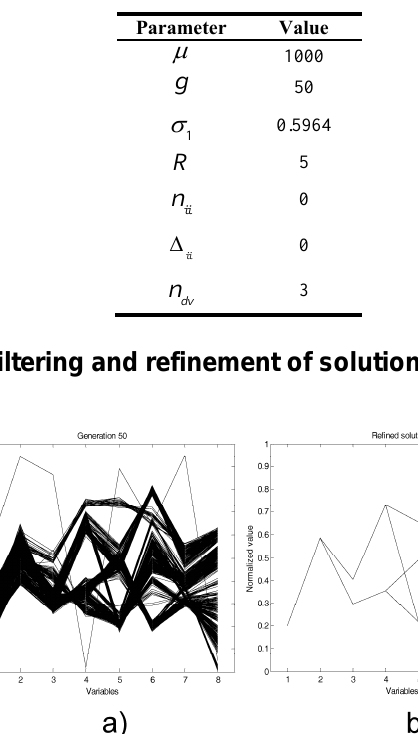
Table 7. Parameters of DDM-ES